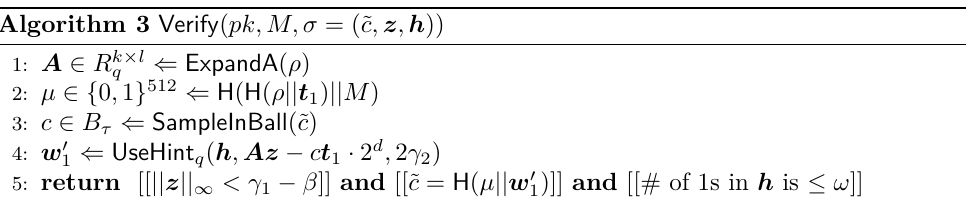
Algorithm 3 Verify ( pk, M, σ = (˜ c, z , h ))